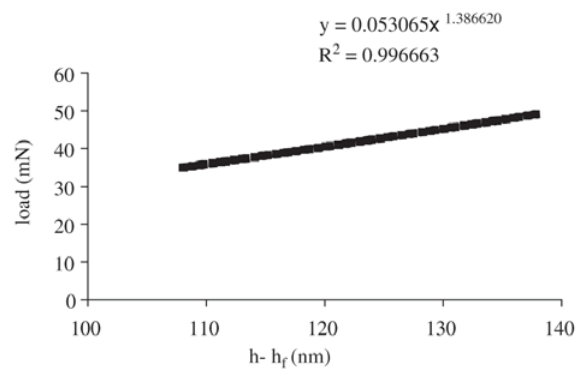
Figure 6. Unloading curve fitted by a power law relation of the form P = A (h - h ) m f